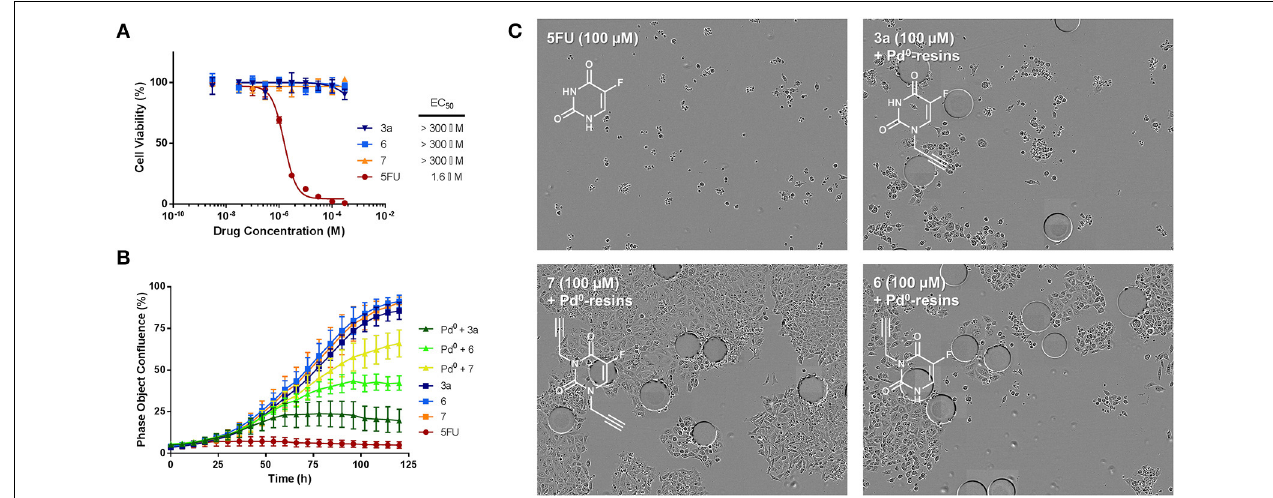
FIGURE 4 | (A) Study of prodrugs’ bioorthogonality. Semi Log dose response curves and calculated EC 50 values of prodrugs 3a , 6 , and 7 in comparison to unmodified 5FU ( 1 ) in HCT116 cells. Cell viability was measured at day 5 using PrestoBlue™ reagent. Error bars: ± SD from n = 3. (B) Bioorthogonally-activated toxigenic effect in HCT116 cancer cell culture: Real-time cell confluence study. The cell population was monitored for 120h using an IncuCyte ZOOM system in an incubator